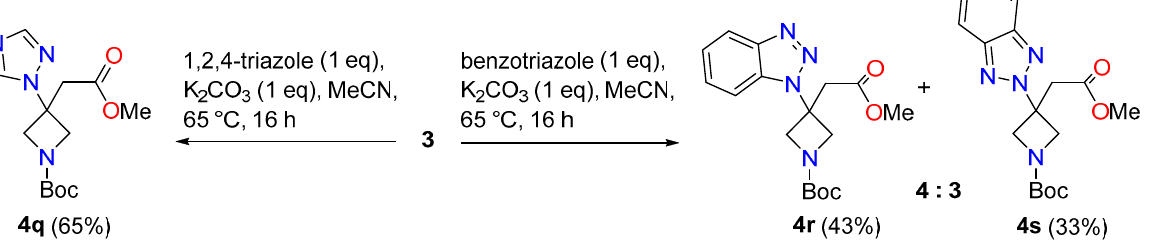
Table 1. Optimisation of reaction conditions of compound 4q .